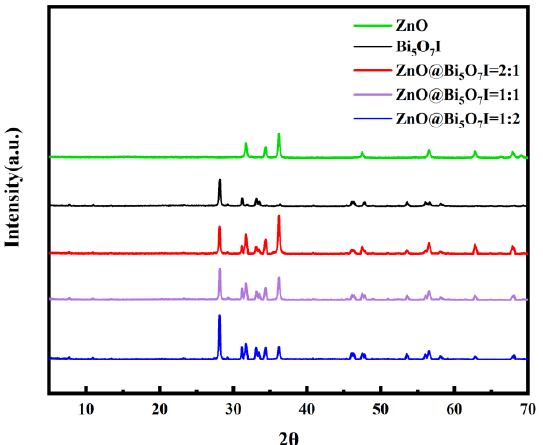
Figure 1. The X-ray diffraction spectra of the Bi 5 O 7 I, ZnO, and ZnO@Bi 5 O 7 I composites with different sample